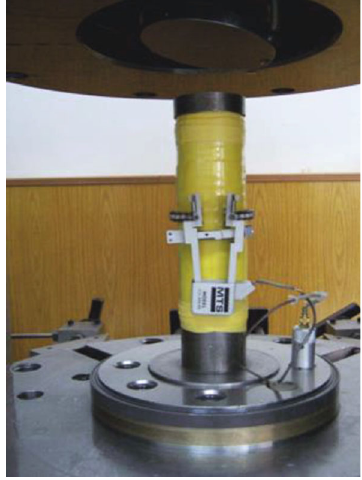
Figure 5: Rock specimen placed on MTS815 system.